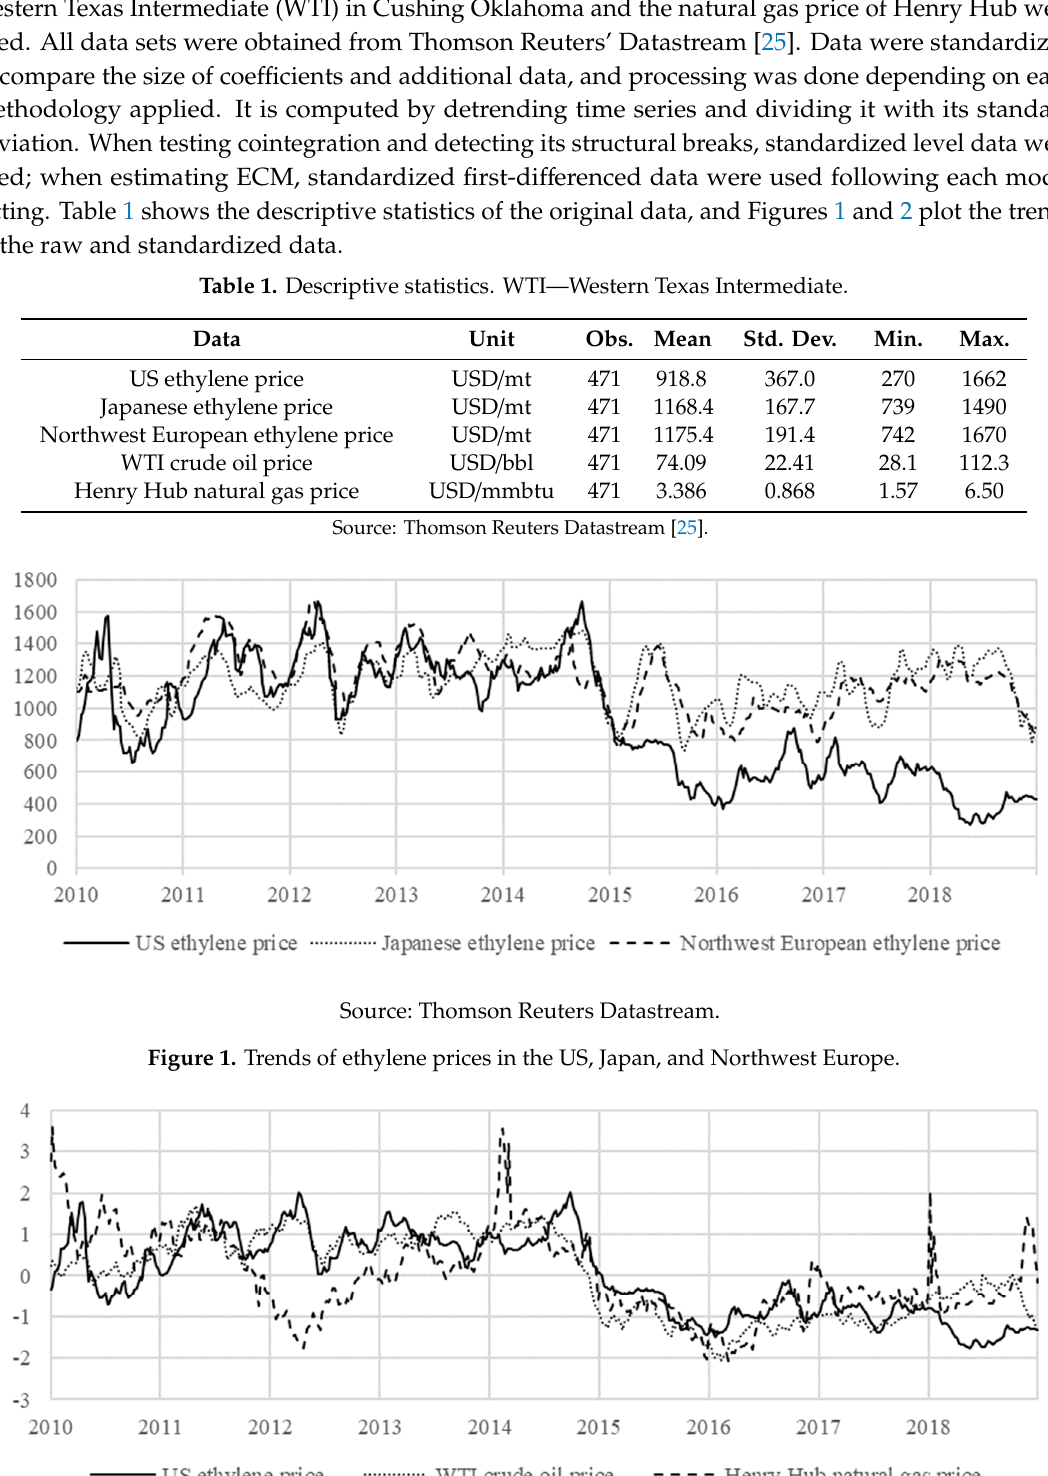
Table 1. Descriptive statistics. WTI—Western Texas Intermediate.